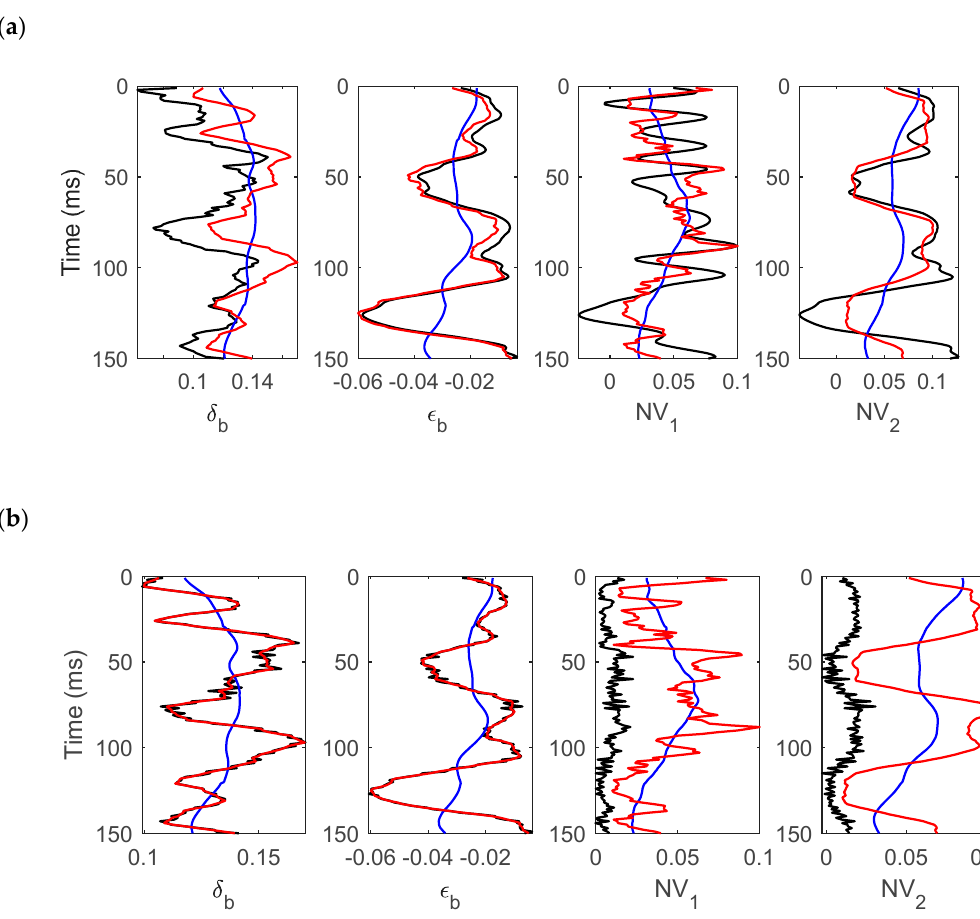
Figure 6. Inversion results using synthetic data (Figure 4a), computed with the fracture radius at 10 m and fracture width at 1 mm. ( a ) Inversion results with the forward operator that the fracture radius was 0.25 m, ( b ) Inversion results with the forward operator that the fracture width was 5 mm.